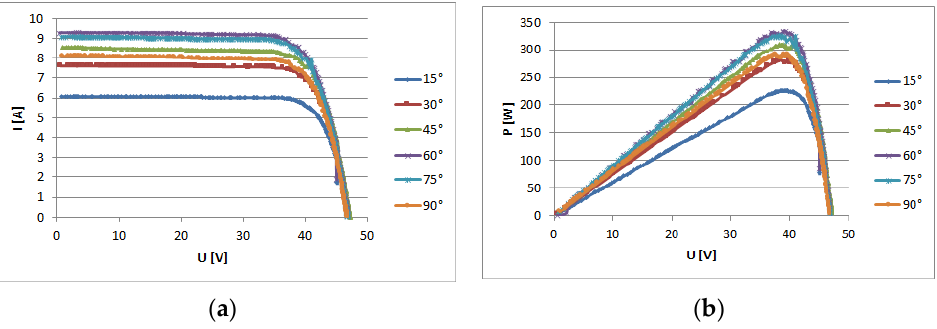
Figure 7. The bifacial module’s characteristics for grass substrate: ( a ) current-voltage characteristics; ( b ) power-voltage characteristics. Table 4. Results of measurements and calculations for a grassy substrate.